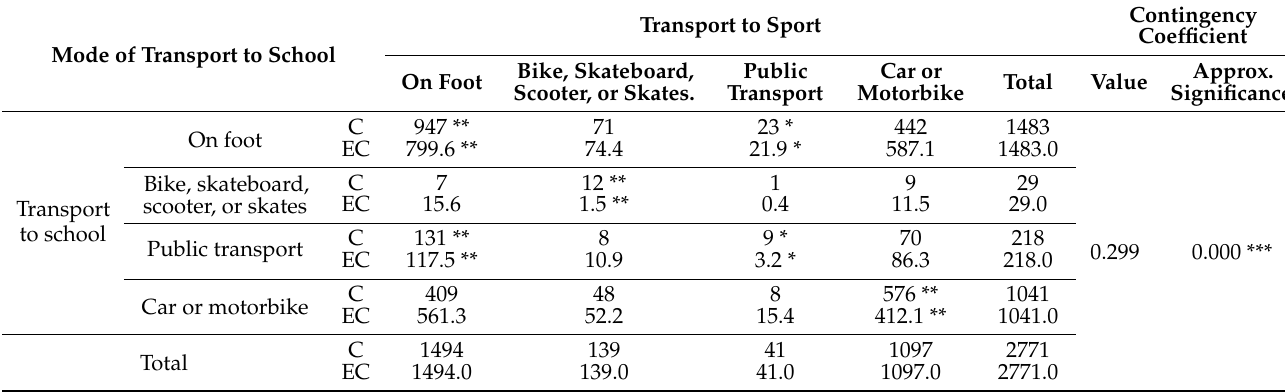
Table 3. Contingency between the variables “mode of transport to school” and “mode of transport to sport” in females.